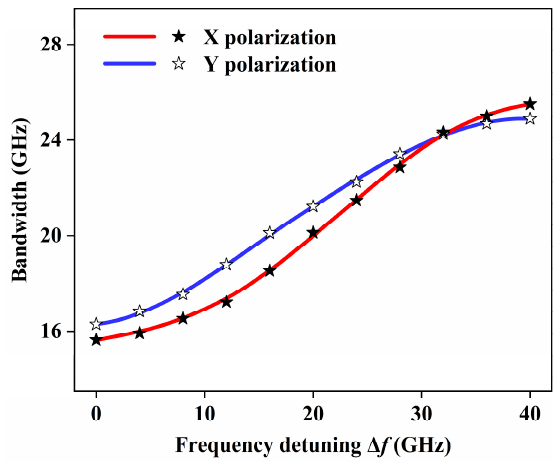
Figure 5. The variation of polarization chaos bandwidth for XP and YP modes of VCSEL1 with the frequency detuning.